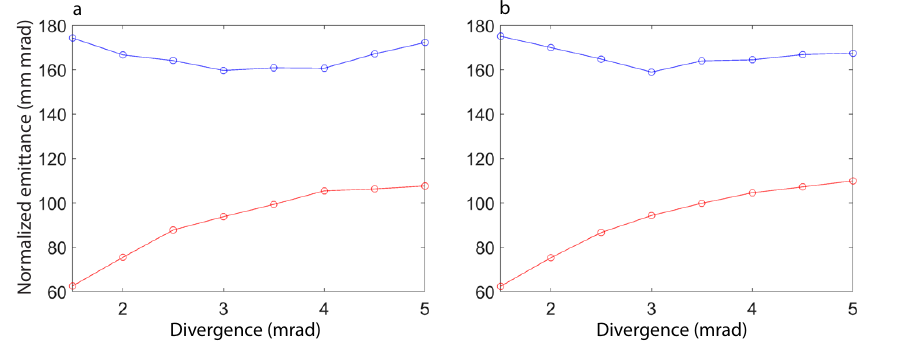
Figure 11. Vertical ( blue ) and horizontal ( red ) normalized emittance versus the initial vertical divergence at the undulator center for the low ( a ) and high ( b ) skew case (Table 2) with the low divergence electron distribution (see Figure 2a, Table 1) and the “undulator” optics.